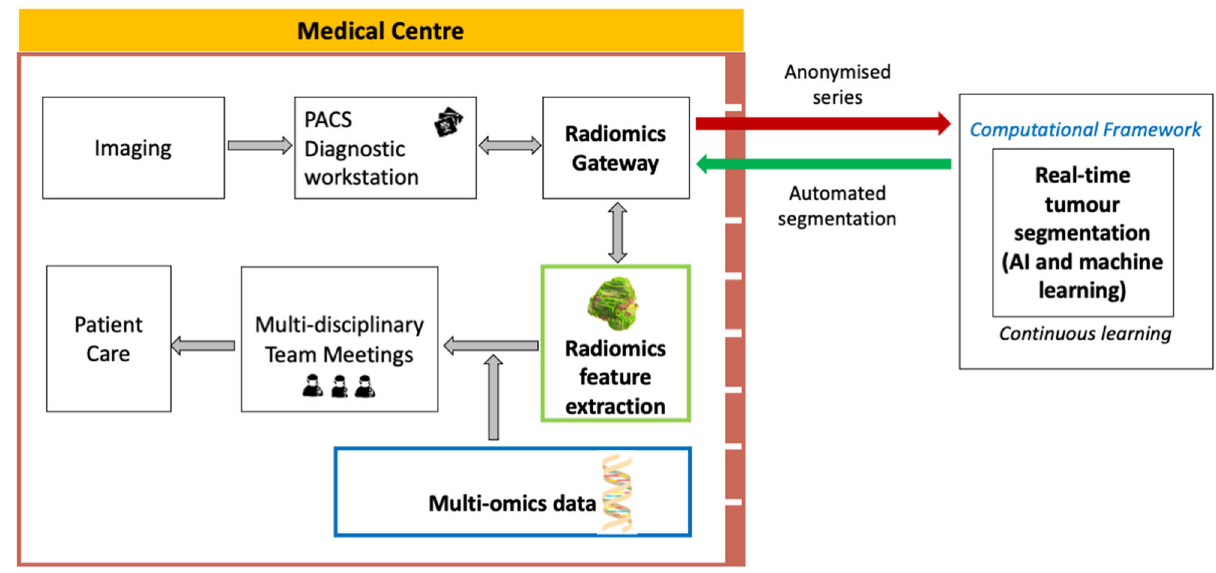
Fig. 5 Potential future real-time tracking of whole tumour volume, spatial and temporal phenotypic heterogeneity with multi-omics data integration for precision oncology. This schema would allow the processing of multi-institutional data, where each medical centre acquires and stores (in local PACS) its own medical imaging data. To execute quantitative analyses, a radiomics gateway is used to communicate outside the institution by requesting an automated, real-time tumour segmentation from a trusted and specialised AI/ML centre, which allows for continuous learning. The medical images leaving the hospital are anonymised to deal with cyber-security and privacy issues. The segmentation results are used for radiomic feature extraction and analysis, acting as virtual biopsies. The quantitative imaging results are integrated with other biomedical data streams to determine associations with clinical and multi-omics information. Such an approach may develop reliable diagnostic and prognostic tools for multidisciplinary team meetings to improve cancer care in clinical practice; and the evolution of precision oncology. PACS Picture Archiving and Communication System, ML Machine